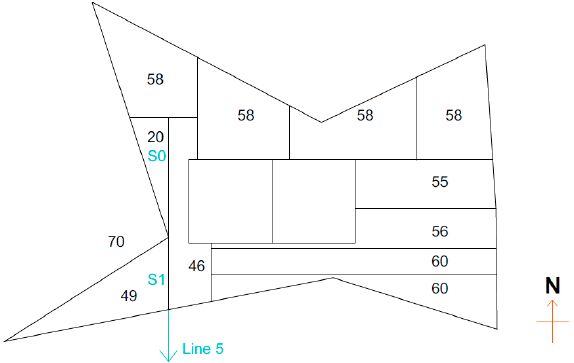
Figure 4. Ignored scenario for splitting the layout. Note: The numbers (m 2 ) in the layout are the corresponding room areas.